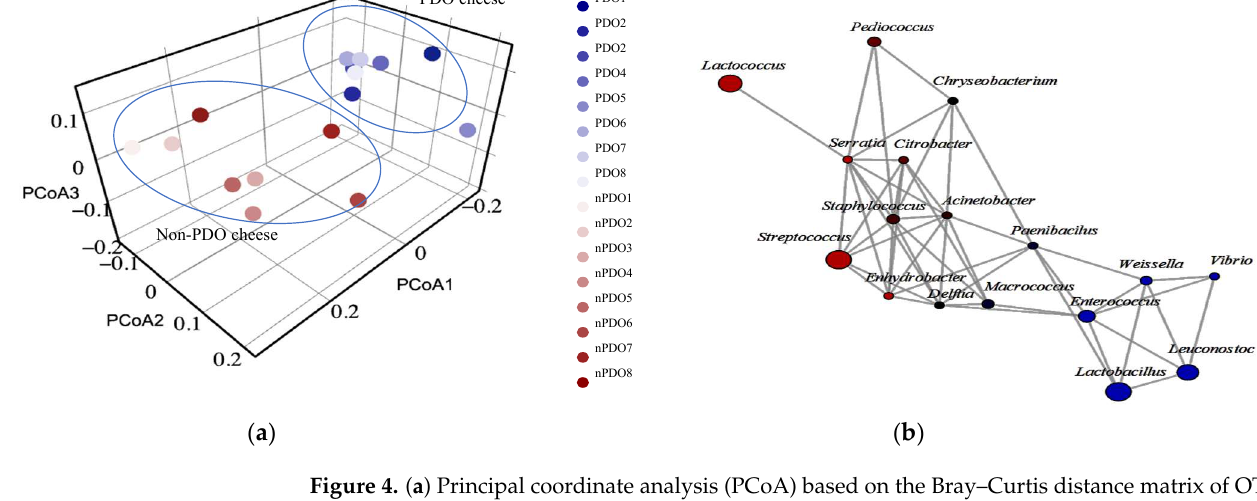
Figure 4. ( a ) Principal coordinate analysis (PCoA) based on the Bray–Curtis distance matrix of OTUs identified at the genus level of PDO and non-PDO cheese samples. The ellipses were drawn by hand to help visualizing the different cheese types. ( b ) Correlation network of co-occurrence patterns of OTUs classified at the genus level between non-PDO cheeses (red circles) and PDO cheeses (blue circles). The size of each node indicates the richness of OTUs belonging to each taxonomic group. Lines connecting two nodes represent significant positive correlations ( p < 0.05).